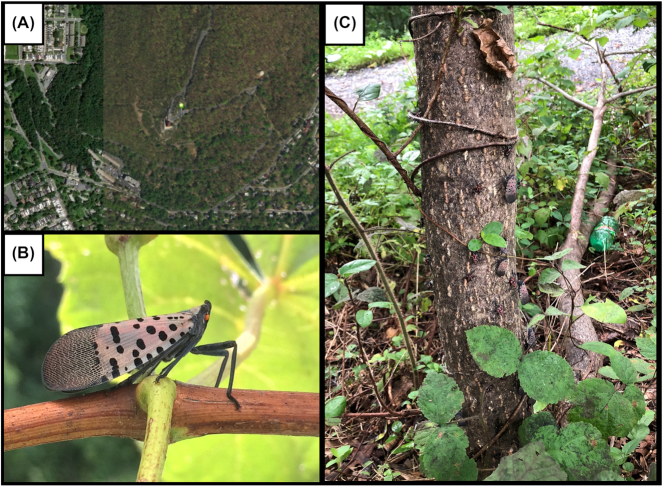
w. (A) Location of specimen collection (green marker), near the Reading Pagoda on Mt. Penn (Reading, Berks County, Pennsylvania, USA [40.33648 N, 75.90471 W]); (B) adult female Lycorma delicatula; (C) the host Ailanthus altissima tree (tree of heaven) from which the female adult sample was collected on 26 August 2018. Late nymph stage and adults can be seen covering the trunk of this host tree.